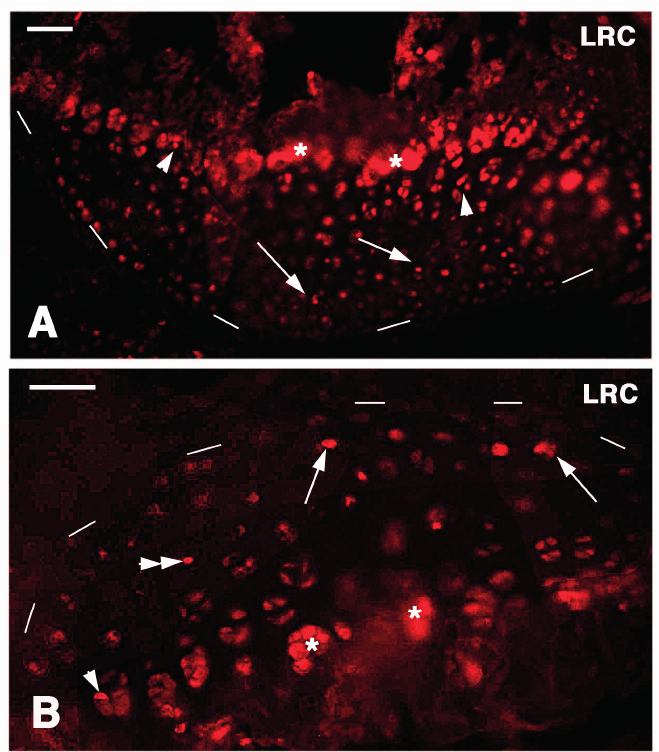
Figure 6. Detail on the femur ( A ) and tibia ( B ) articular surfaces (outlined by dashes) for Long Retaining Cells. ( A ) Arrows indicate some labeled cells inside the cartilage while arrowheads indicate labeled cells in the serial cartilage of the metaphyseal growth plate (asterisks indicate non-specific labeling of the mineralized matrix). Bar, 50 µm; ( B ) arrows indicate surface labeled cells, the double arrowhead point to cells within the cartilaginous tissue while the arrowhead indicates a labeled cells in the serial cartilage of the metaphyseal growth plate. Asterisks indicate non-specific labeling of the mineralized matrix around chondrocytes. Bar, 50